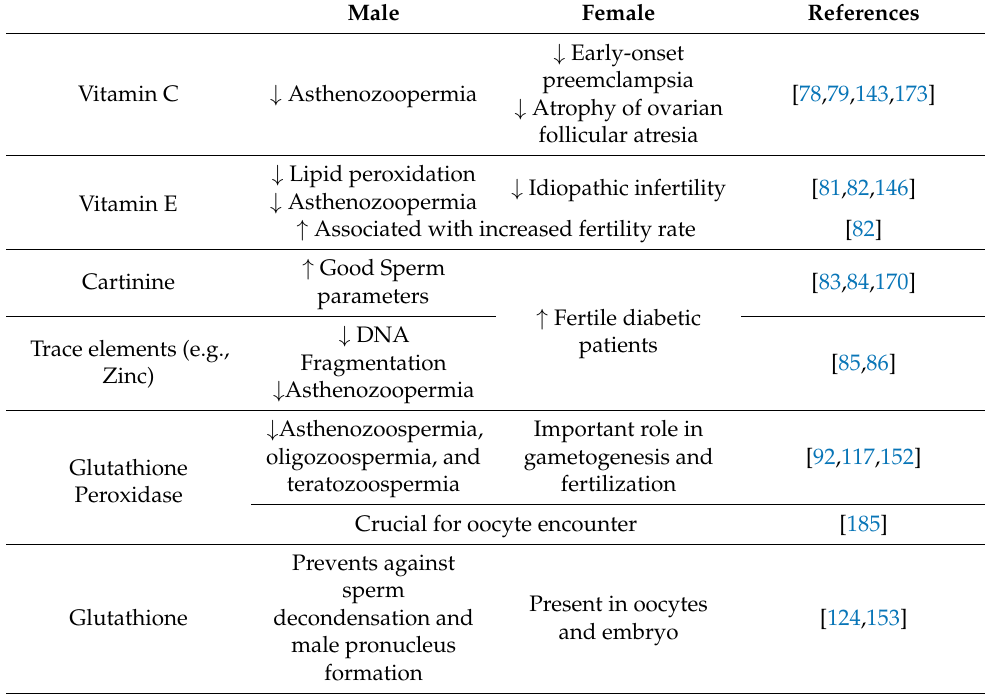
Table 2. Main antioxidant nutrients and enzymes present in male and female reproductive tract fluids and its relationship with fertility parameters. Arrows illustrate the levels of the nutrients/enzymes in the conditions presented. ↓ decreased and ↑